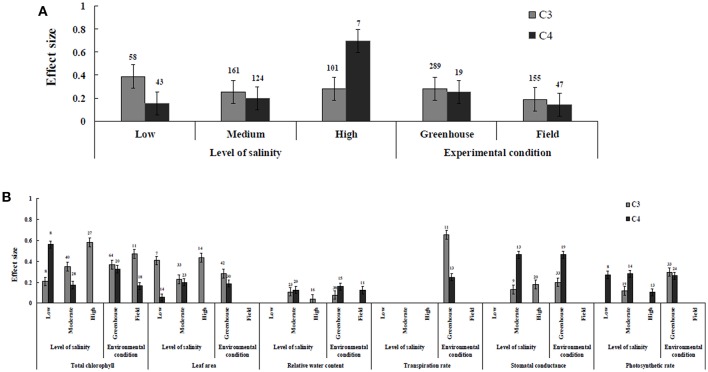
The level of salinity and environmental conditions—categorical analysis. (A) Overall level of salinity and environmental conditions response to gas exchange and water status. (B) Individual response variables reaction to level of salinity and environmental conditions. Error bars are means ± BS CIs. Where the CIs do not overlap each other, the effect size for a parameter is significant at P < 0.05. The number of trials included in the meta-analysis is denoted above the bar.